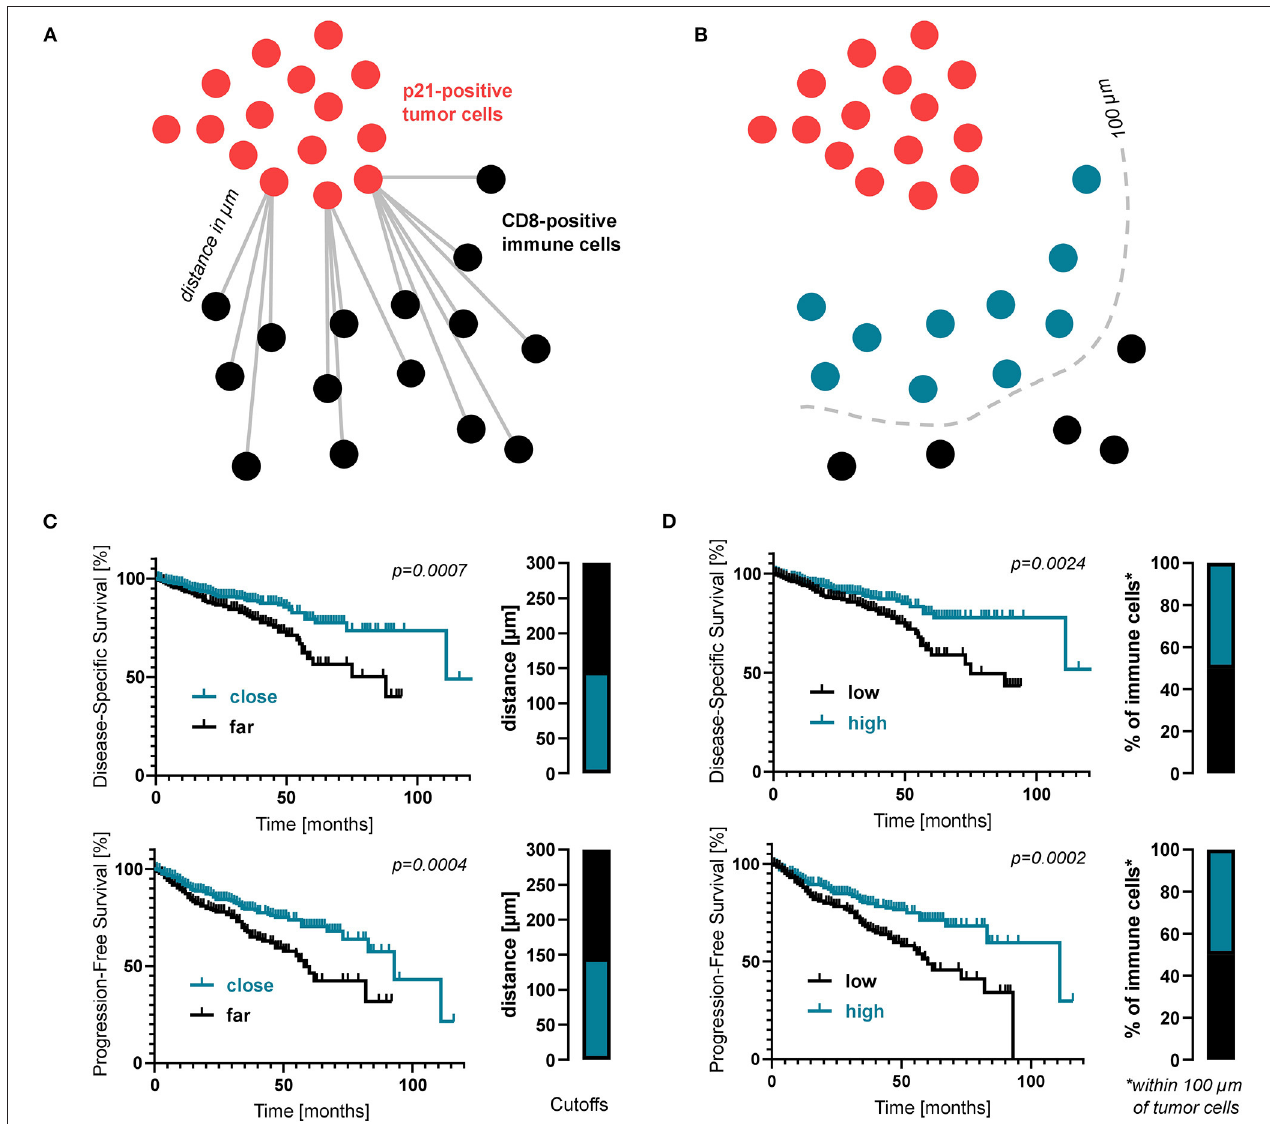
FIGURE 3 | Proximity analysis of senescent cells and immune cells in CRC patients. (A) Schematic drawing of how the distance between immune cells and senescent tumor cells was measured. (B) Kaplan-Meier survival analyses regarding the average distance between CD8- and p21-positive cells. (C) Schematic drawing of how the proportion of immune cells within close proximity (within 100 µ m) of senescent tumor cells was measured. (D) Kaplan-Meier survival analyses regarding the percentage of CD8-positive cells within 100 µ m of p21-positive cells. Again, cutoff values are displayed as bar